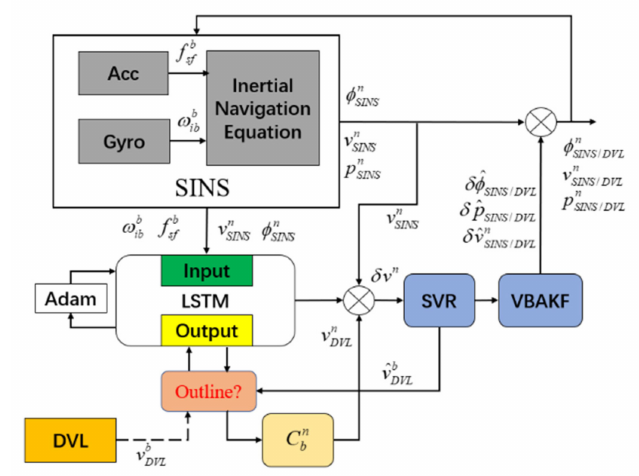
Figure 5. Schematic diagram of deep learning model-assisted navigation system.